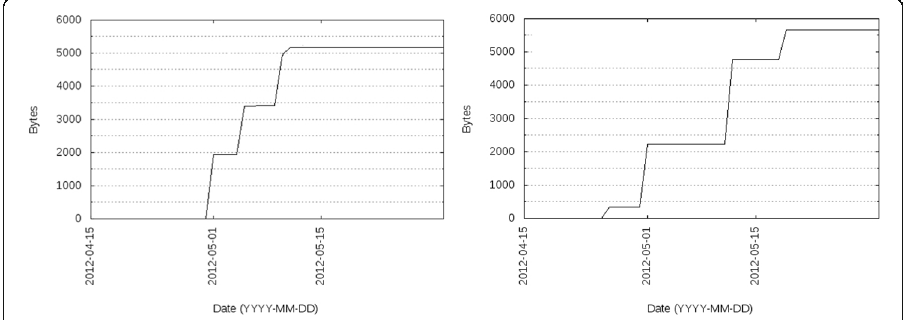
Fig. 7 Content evolution chart for User15 (left) and User14 (right) obtained via